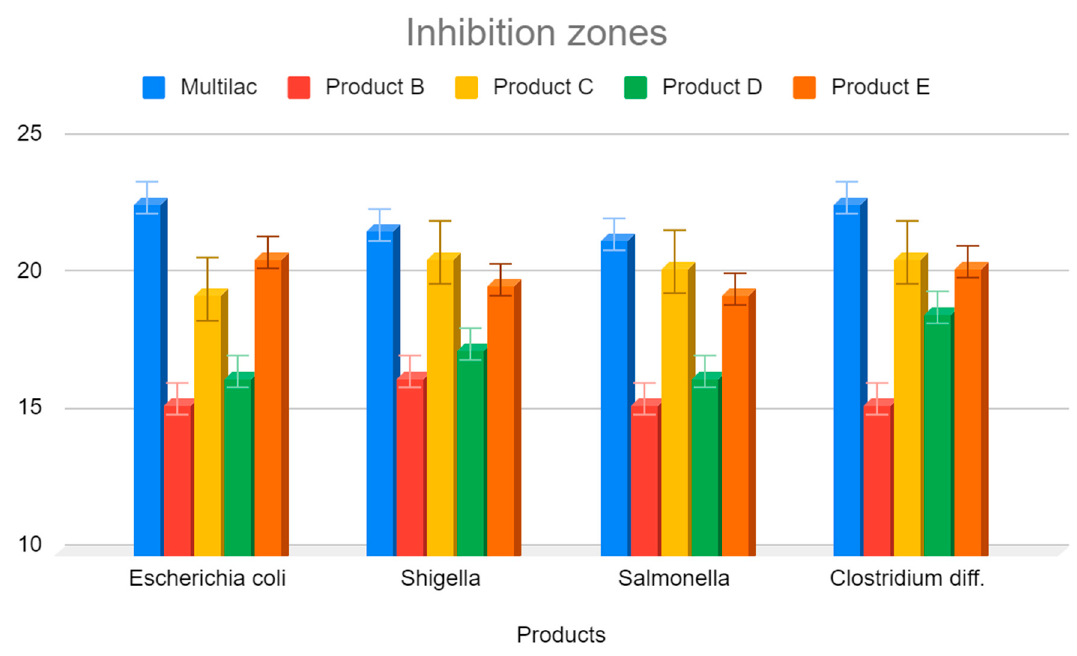
Figure 5. Zones of inhibition of tested probiotics against pathological gastrointestinal bacteria. Arithmetic mean of 3 independent experiments.